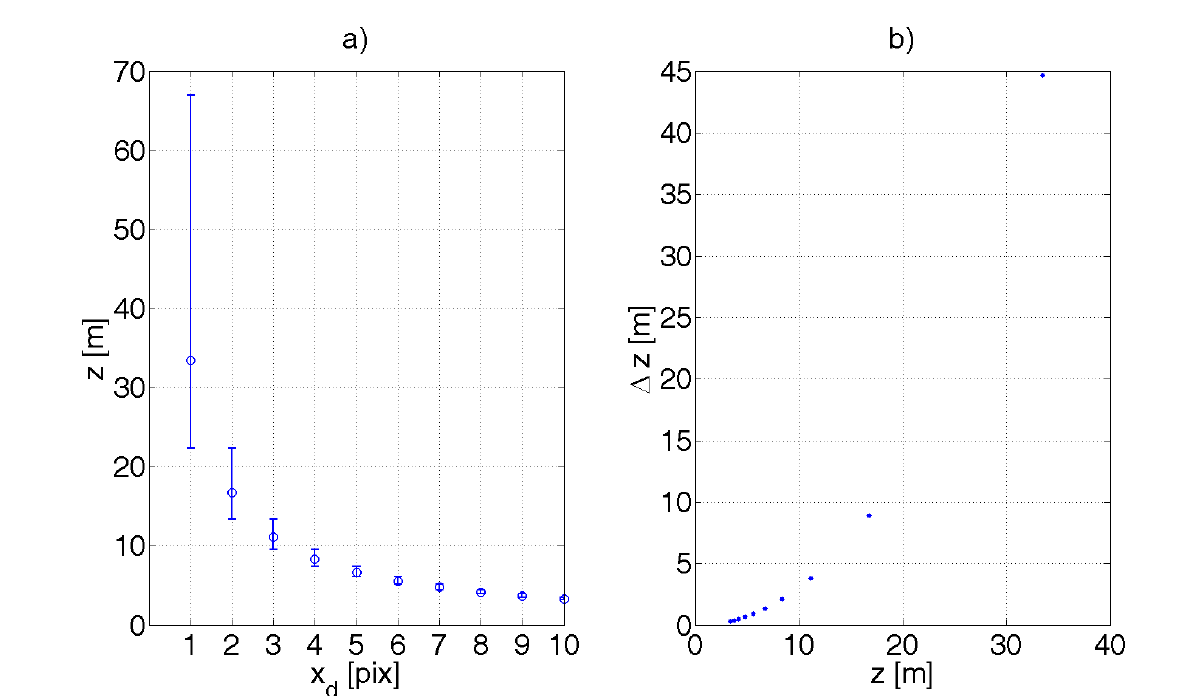
. Dots symbolize the depth d is encumbered with an d